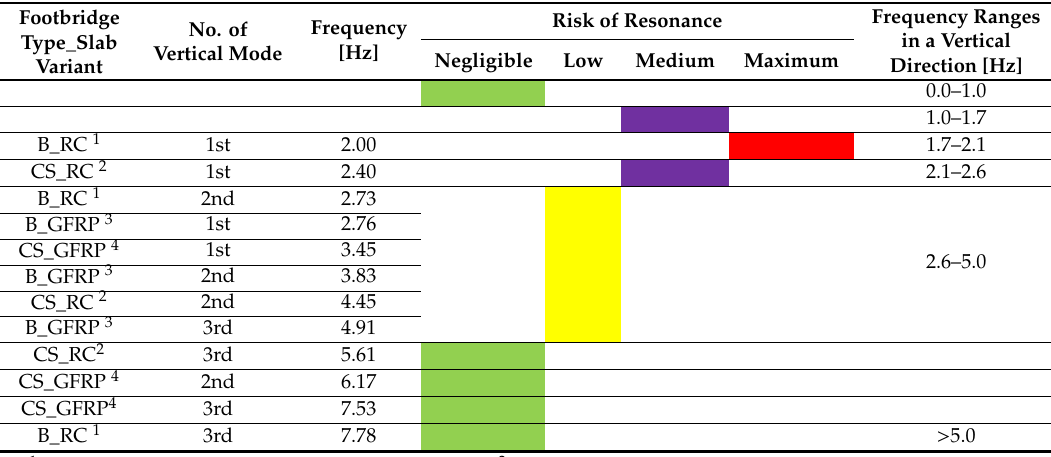
Table 15. The risk of resonance assessment for: the cable-stayed footbridge with the RC slab